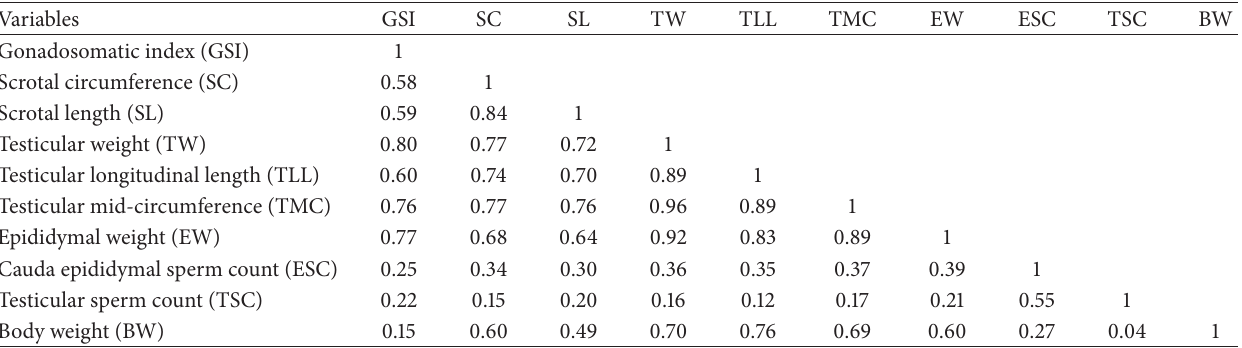
Table 2: Correlation coefficients ∗ ( 𝑟 ) in matrix of relationships among testicular and related variables and associated sperm